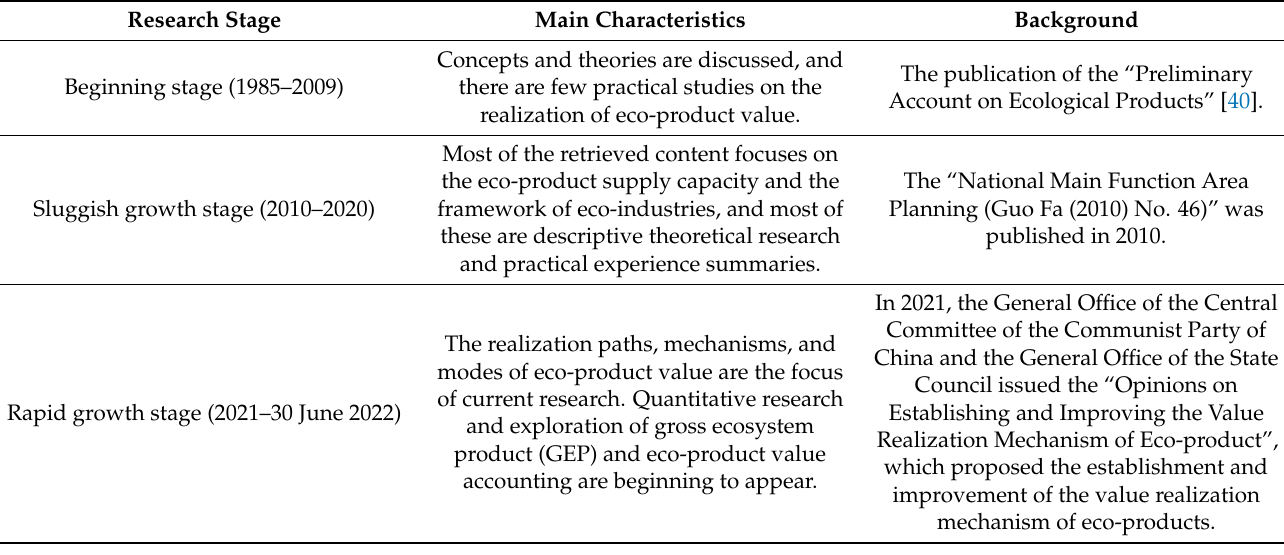
Table 1. Division of the stages of the research.